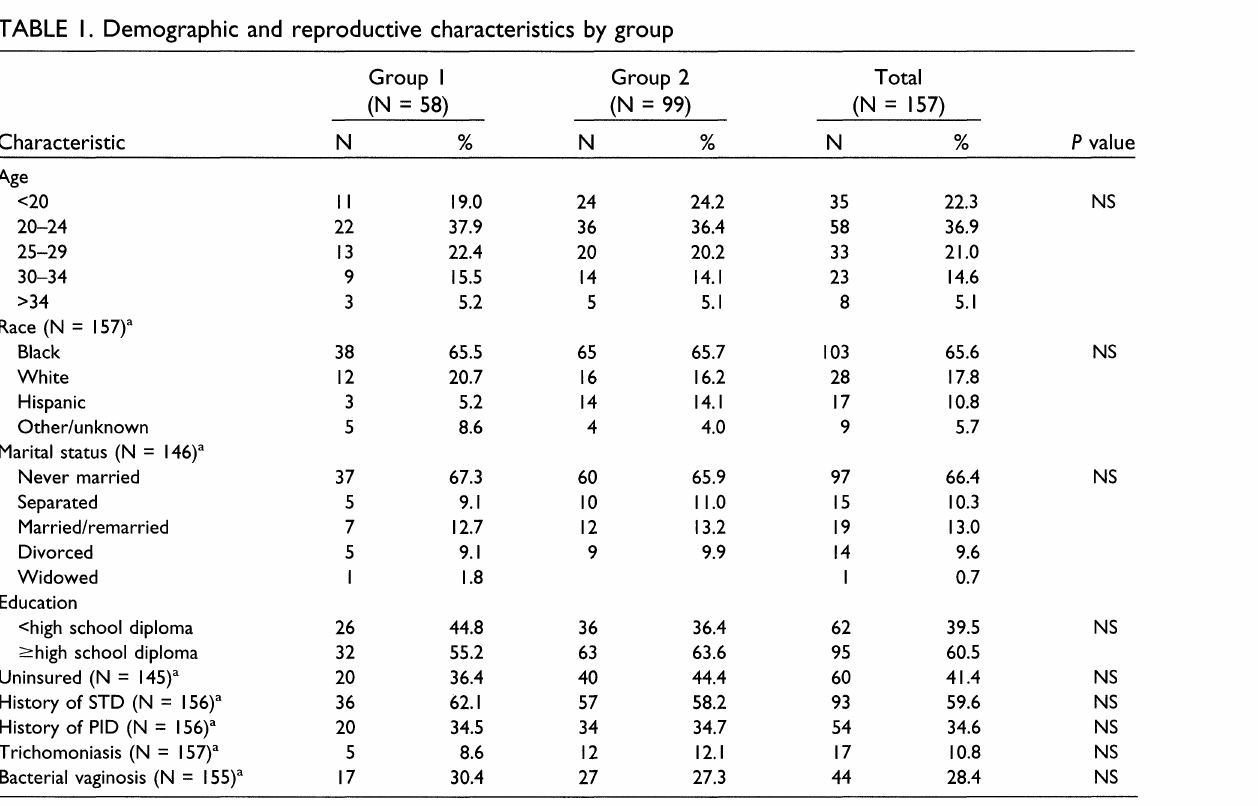
TABLE I. Demographic and reproductive characteristics by group Characteristic